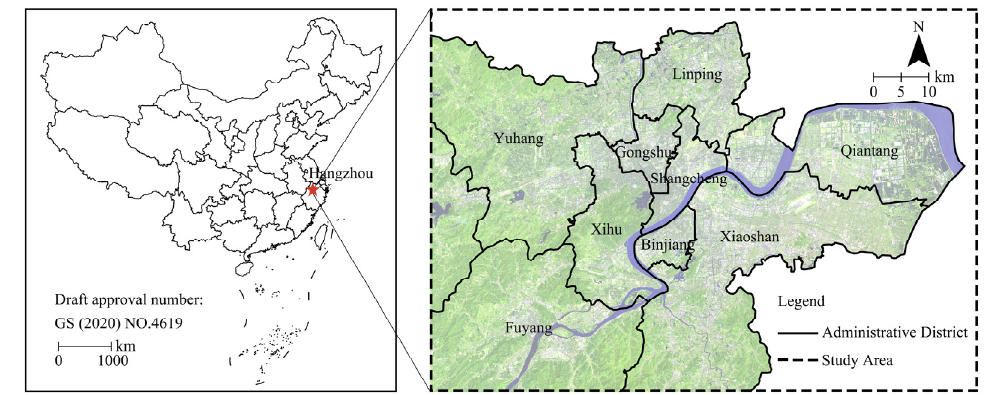
Figure 1. Location of the study area in Hangzhou, China.